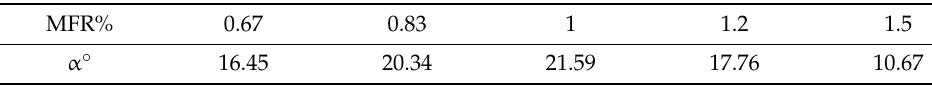
Figure 12. Radial location of the velocity peaks with streamwise distance for different amplitudes. Table 1. Bifurcation angle under different amplitudes.